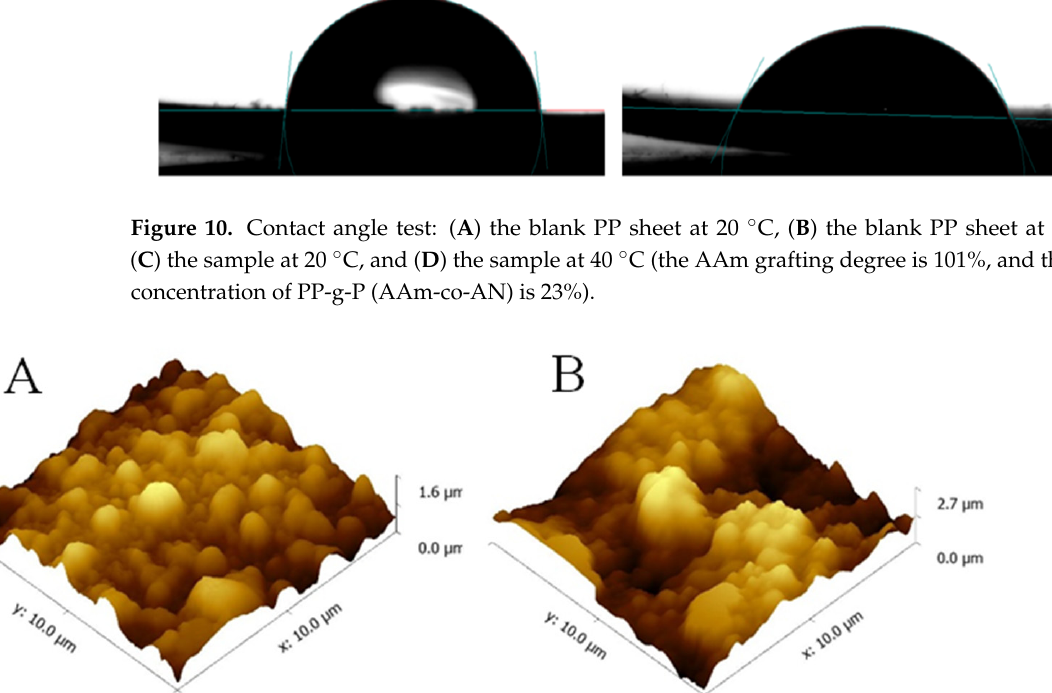
Figure 10. Contact angle test: ( A ) the blank PP sheet at 20 °C, ( B ) the blank PP sheet at 40 °C, ( C ) the sample at 20 °C, and ( D ) the sample at 40 °C (the AAm grafting degree is 101%, and the AN concen ‐ tration of PP ‐ g ‐ P (AAm ‐ co ‐ AN) is 23%).